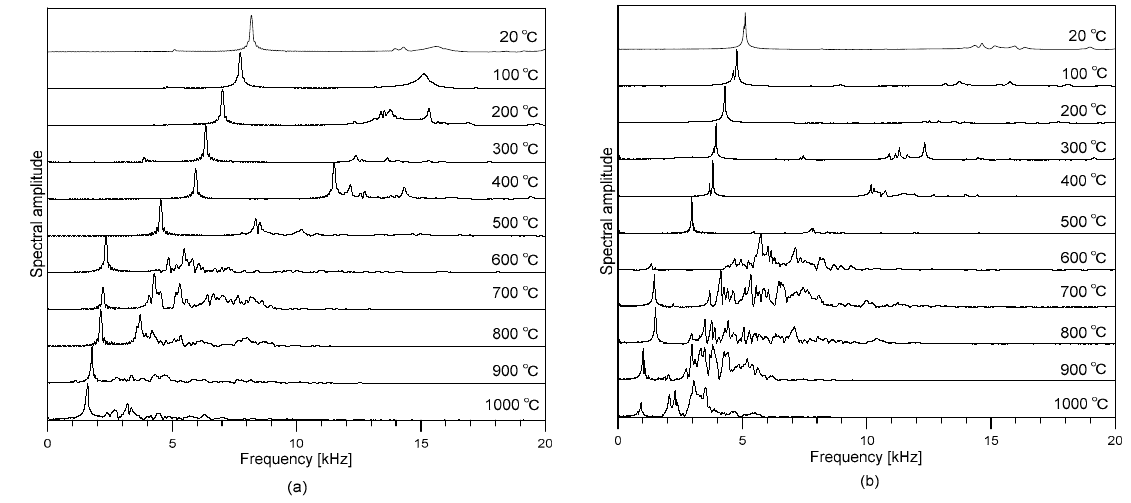
Figure 6. The variations of spectral amplitudes of dynamic response of concrete cylinders obtained from: ( a ) longitudinal and ( b ) transverse resonance vibration testing.